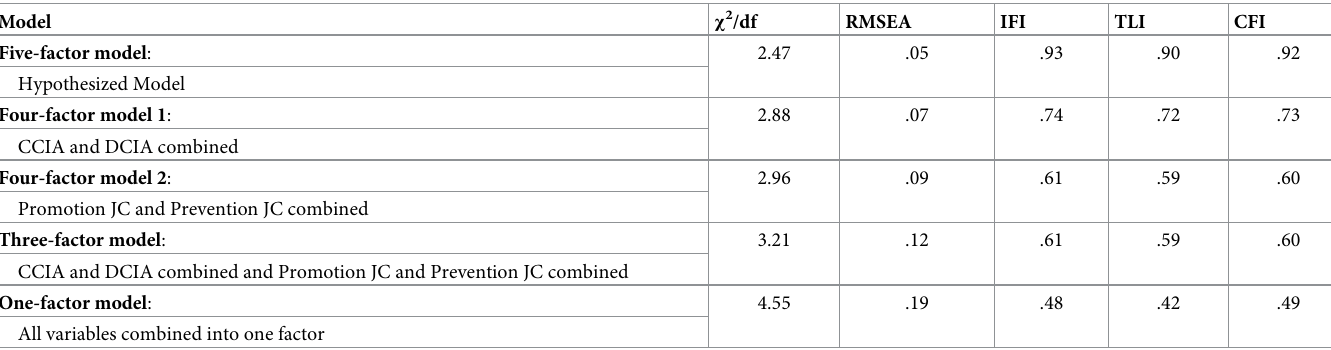
Table 1. Confirmatory factor